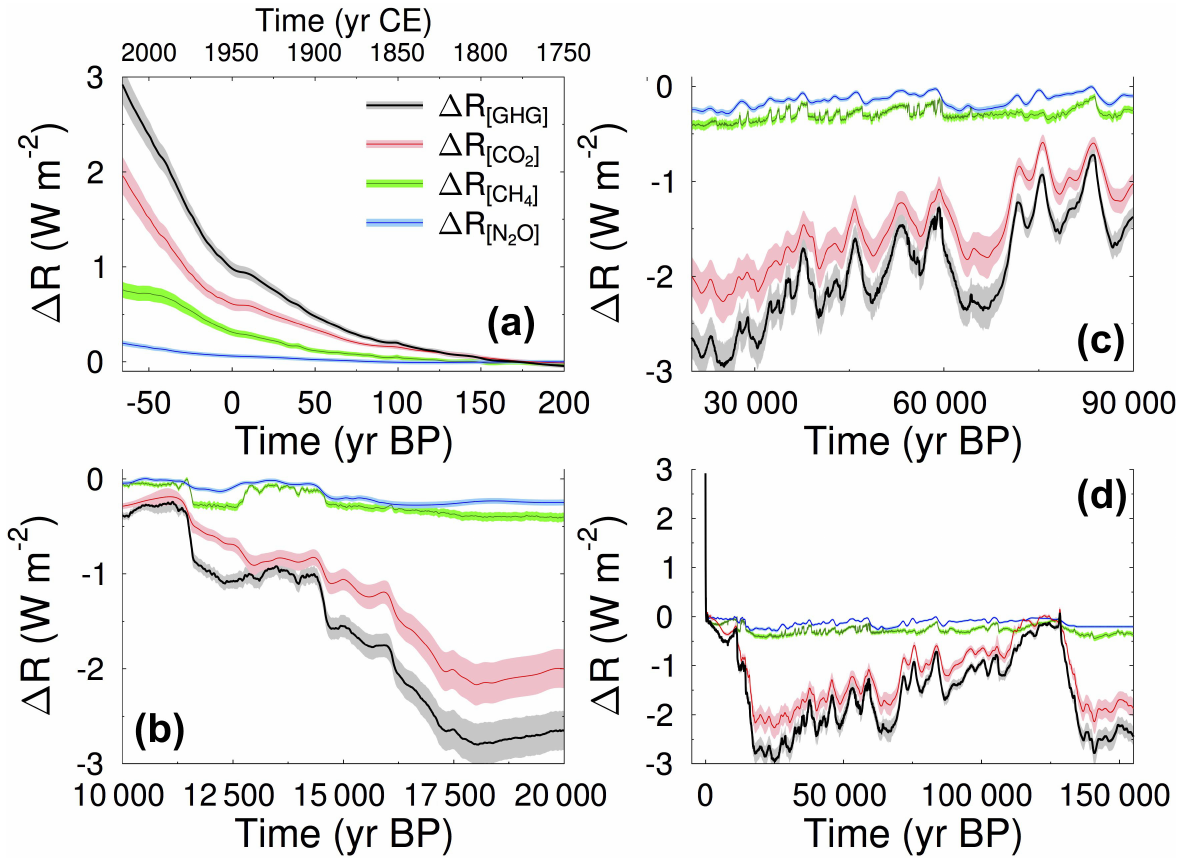
Figure 7. Calculated radiative forcing of CO 2 , CH 4 , N 2 O, and their sum ( (cid:49)R [ GHG ] ), including 1 σ -uncertainty bands. In addition to the uncertainty of the spline, further uncertainties need to be considered: 10% relative uncertainty contained in the simplified Eqs. (3)–(5); 0 . 2Wm − 2 uncertainty in (cid:49)R [ CH and (cid:49)R [ N due to the omission of interaction effects; 5% uncertainty in efficiency of CH 4 (for more 4 ] 2 O ] details, see Köhler et al., 2010). The total uncertainty of the (cid:49)R [ GHG ] is calculated as the square root of the sum of squares of the uncertainties of the individual GHGs. The calculations are based on Eqs. (3)–(5) given in the text (following Myhre et al., 1998). Sub-figures focus on specific time windows: (a) anthropogenic rise since 1750CE; (b) Termination I; (c) 20–90kyrBP, including the abrupt changes during D/O event; (d) full record from 2016CE to 156kyrBP – here N 2 O was kept constant beyond